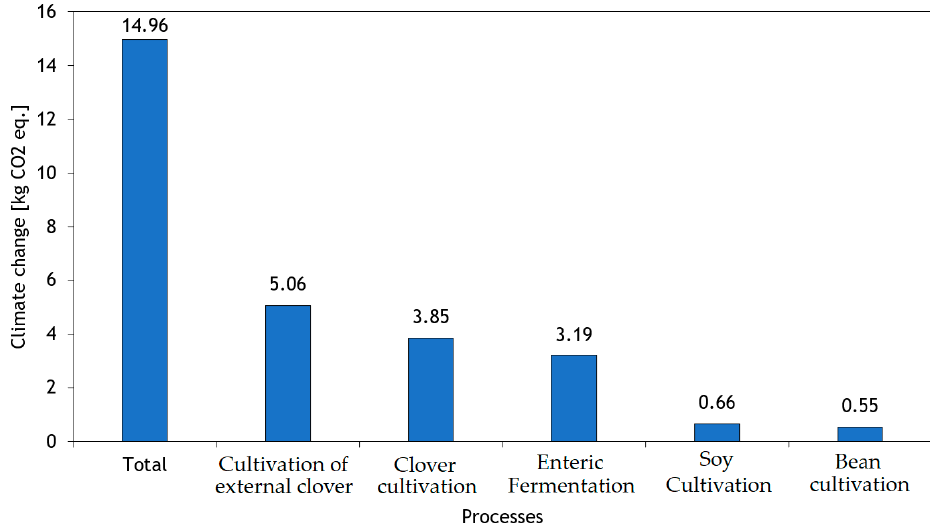
Figure 5. Climate change results associated with each sub-system of the production of 1 kg of cheese.